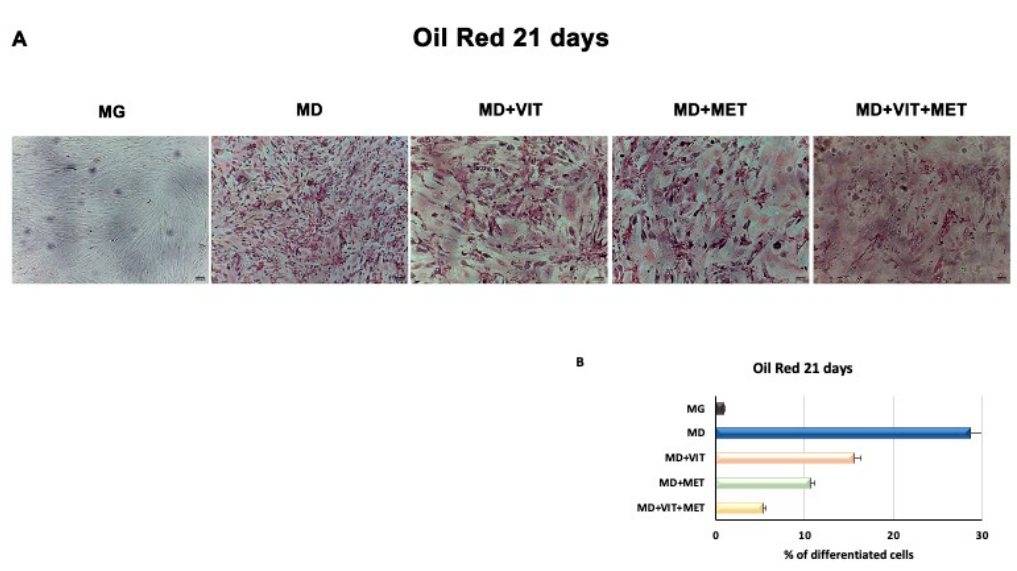
Figure 7. Effect of metformin and vitamin D on lipid accumulation in ADSCs during adipogenic differentiation. ( A ) shows the lipid accumulation in ADSCs cultured in the basic growing medium (MG) or and in the differentiation medium (MD) or the differentiation medium plus vitamin D (MD + VIT) or metformin (MD + MET) or with both vitamin D and metformin (MD + VIT + MET). Scale bar 100 µ m. The amount of lipid accumulation and ( B ) was calculated using ImageJ. Data are expressed as mean ±